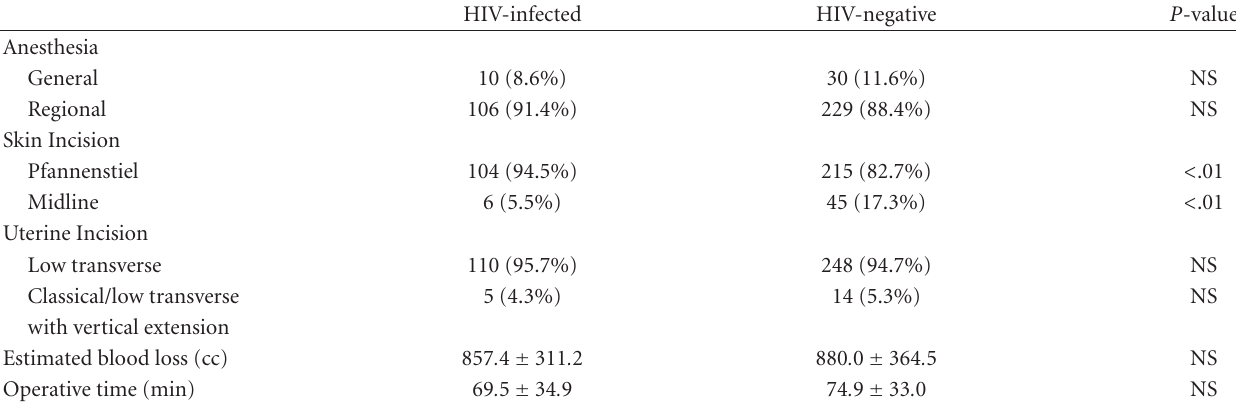
Table 3: Description of surgical